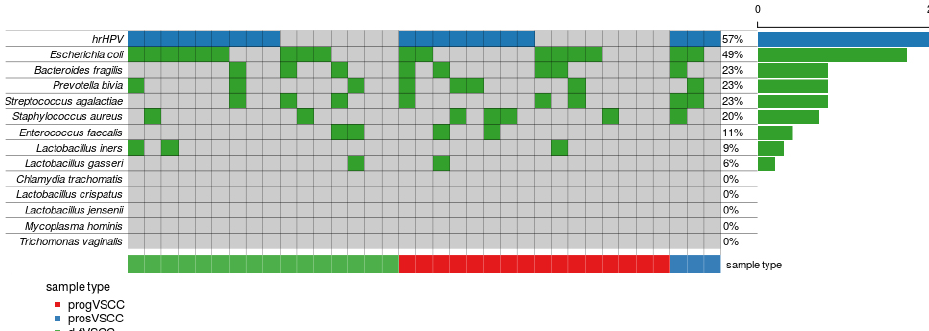
Figure 5. Distribution of bacterial species detected in VSCC samples. Each column corresponds to the individual tumor case (d- fVSCC, n = 16; progVSCC, n = 16 and prosVSCC, n = 3). Each row corresponds to an individual microorganism with its presence or absence depicted in green or grey, respectively. The results of genotyping of 13 vaginal microorganisms is related to hrHPV status of a given tumor with the virus presence or absence depicted in blue or grey, respectively. The values on the x-axis describe the number (0–20) and a percentage of the samples with the presence of a given microorganism.